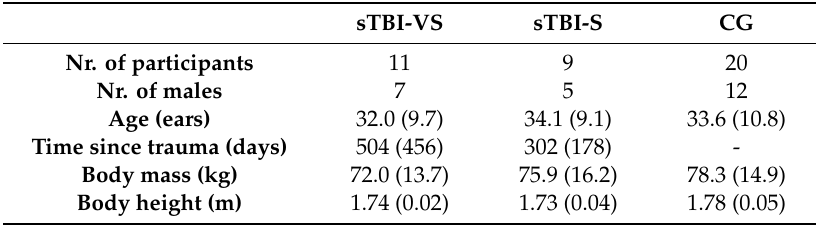
Table 1. Demographic and anthropometric characteristics of very severe Traumatic Brain Injury (sTBI-VS), severe Traumatic Brain Injury (sTBI-S), and control group (CG). Median and interquartile (IQR) values are displayed. Groups were homogeneous in terms of age, body mass, and height ( p > 0.05). sTBI-S and sTBI-VS did not show statistical di ff erences in terms of time since trauma ( p >